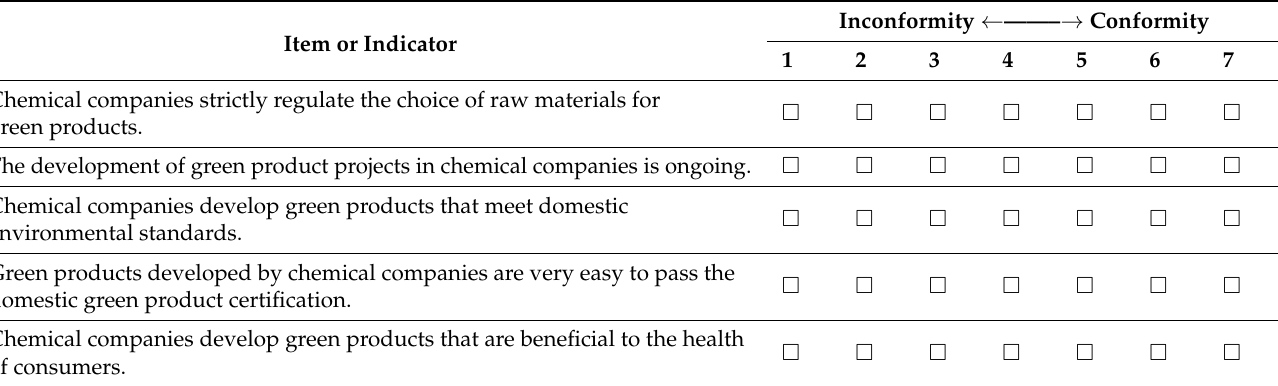
Inconformity ← ——– → Conformity